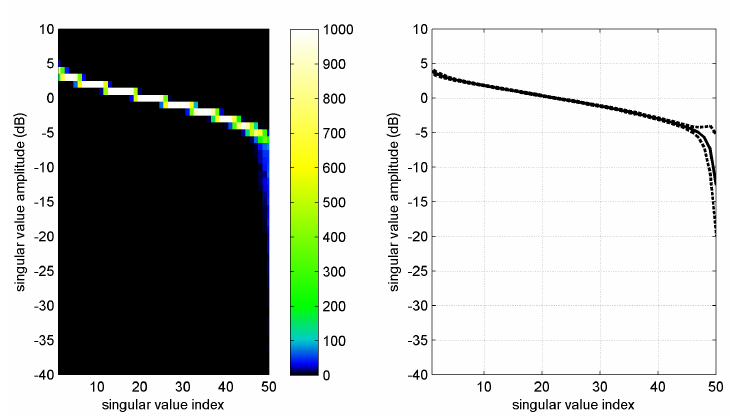
Figure 19. Singular values analysis for the circular array with d = 2 λ and K = 50. ( Left ) Image map of the distribution of each one of the 50 singular values; ( Right ) solid line, average singular values; dashed lines, average singular values ± the standard deviation of the